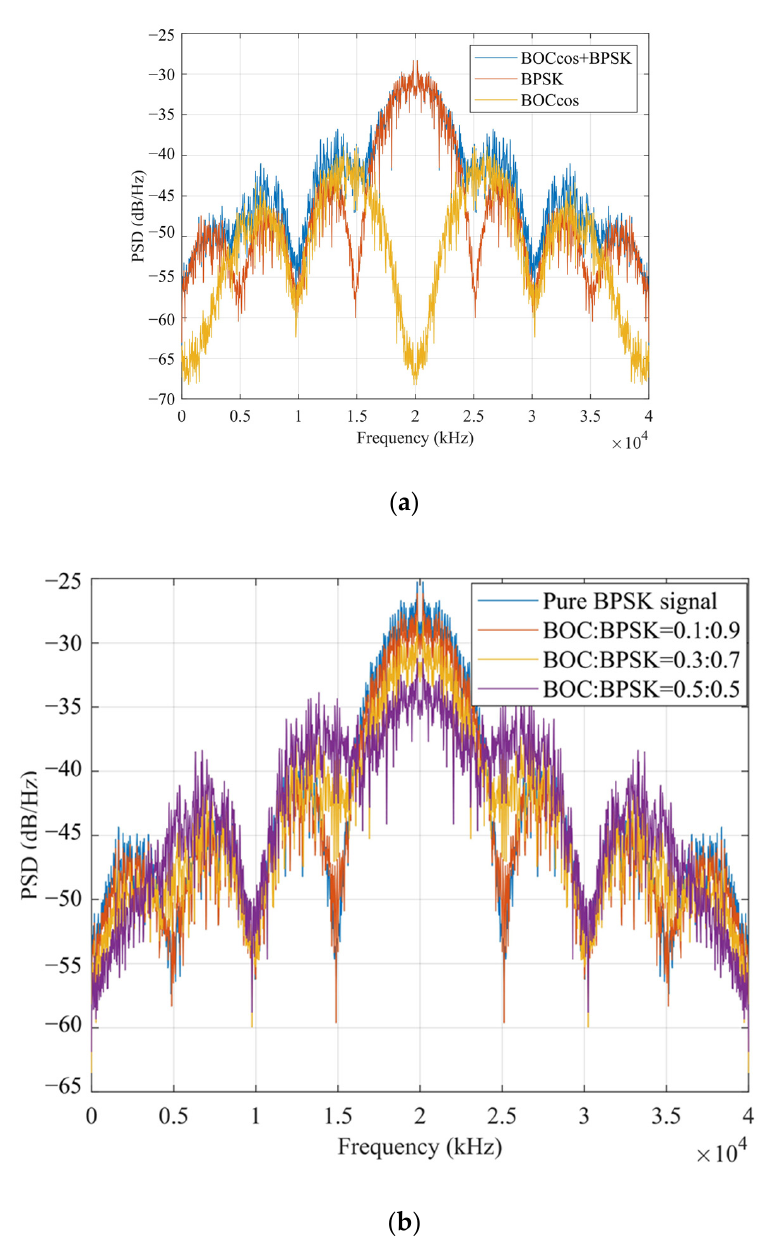
Figure 2. Characteristics of the BOCcos(5,5) and BPSK(5) composite signals. ( a ) α : β = 0.3 : 0.7; ( b ) The power spectrum of different α and β